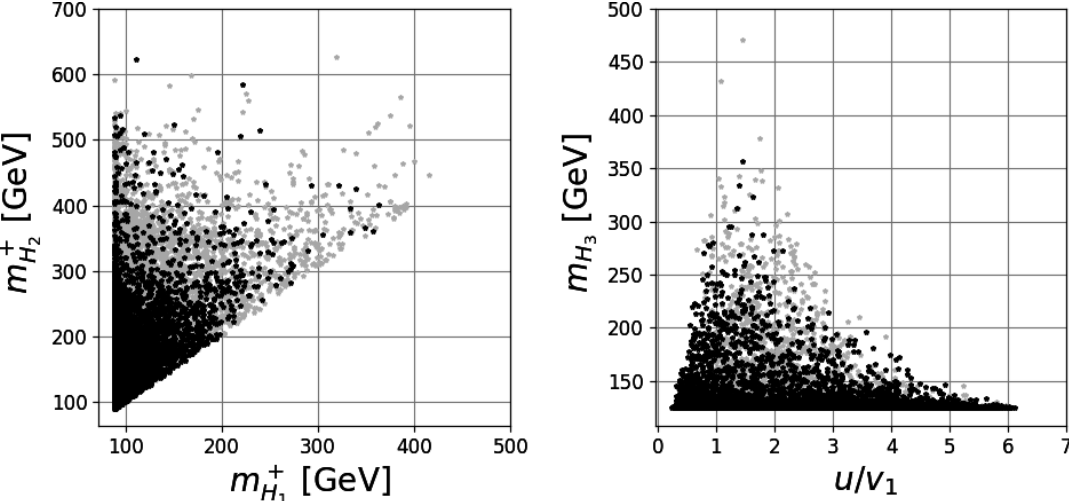
Figure 3 . Left: charged scalar spectrum m + mass dependence with respect to u=v 1